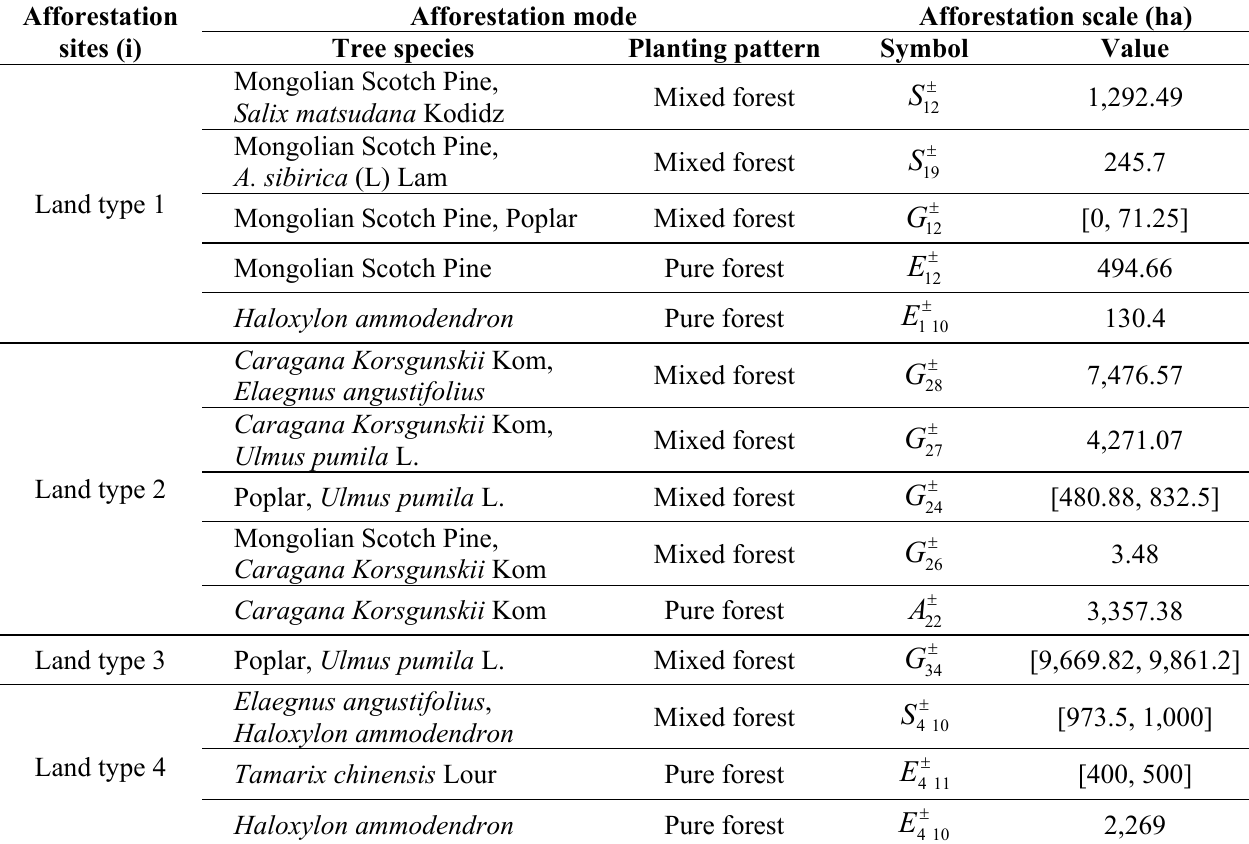
Table 9. Optimal solutions obtained from the